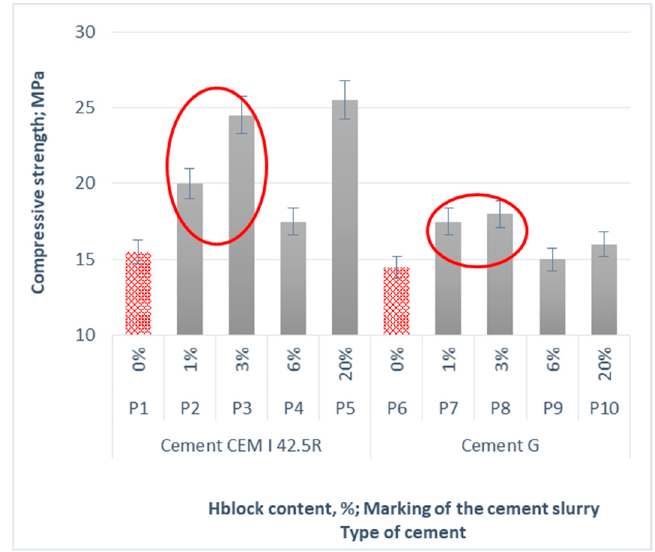
Figure 13. Compressive strength values of the samples of hardened cement slurries. Table 6. Among-subject comparison (comparison of samples with the same amounts of Hblock) t -test: pairwise pairing with two samples for the